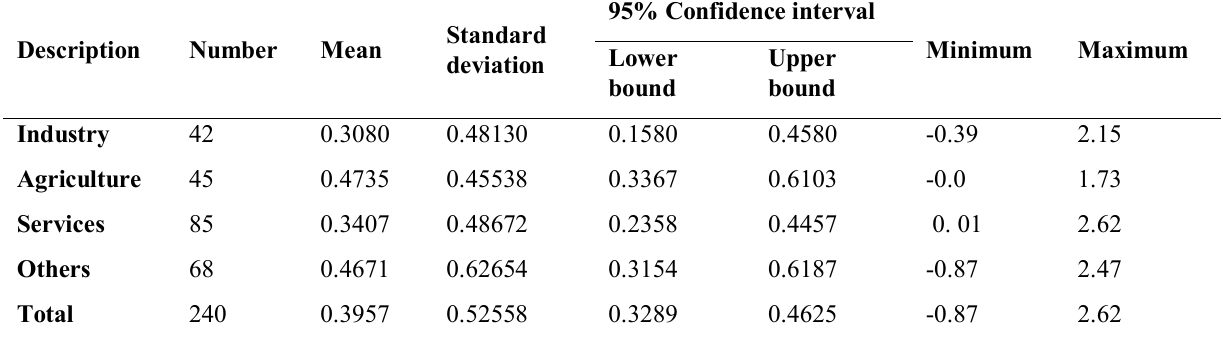
Table 11- ANOVA (Comparing the ROA of different sectors at low investment